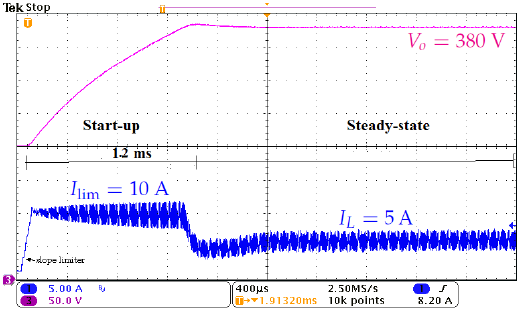
Figure 20. Startup and steady-state responses of the system from experimental measurements with (cid:12) d i ref (cid:12) = 100 kA/s. slope limiter (cid:12) (cid:12) d t lim